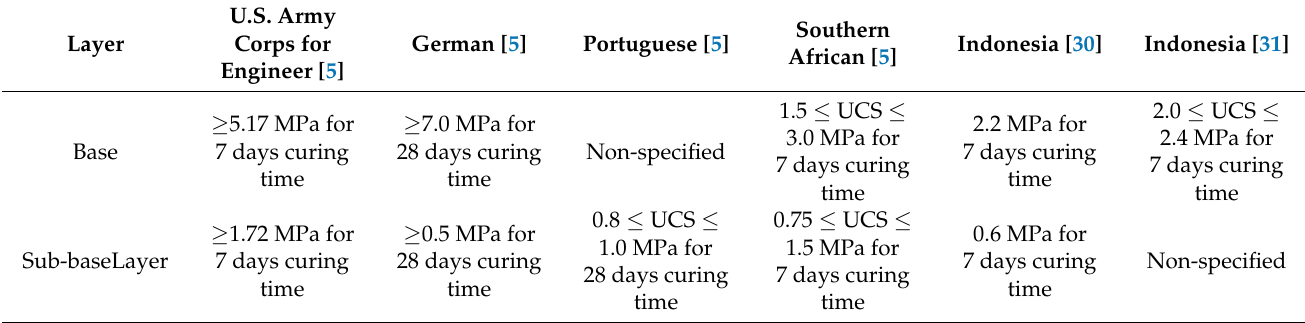
Table 5. Laboratory UCS required for soil–cement mixtures.